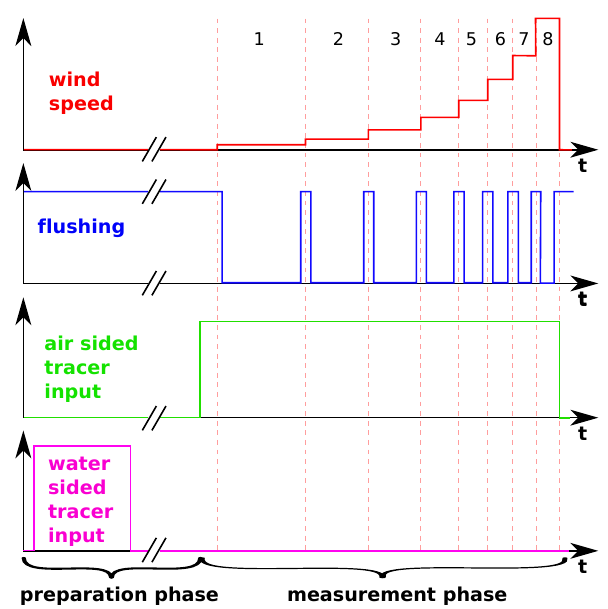
Figure 4. Schematic time series of the wind speed, flushing periods and air/water tracer